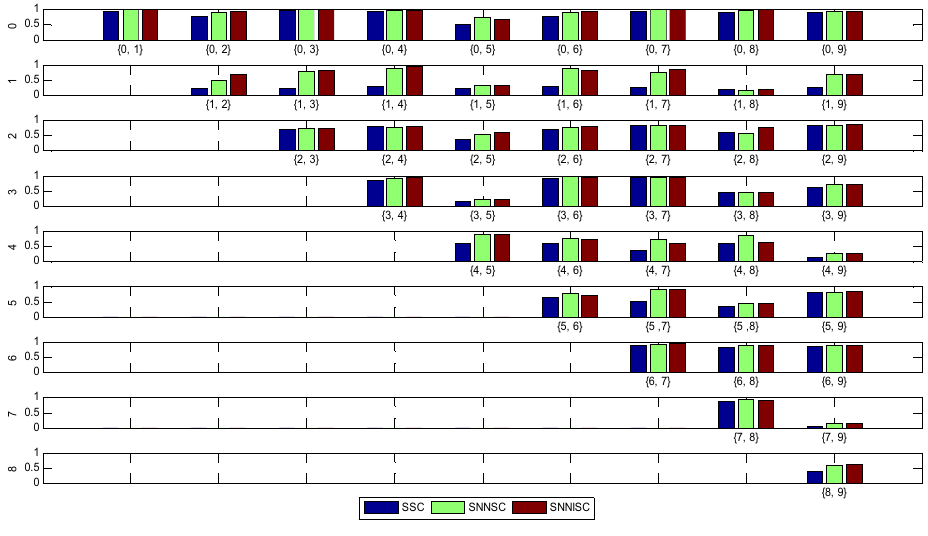
Figure 3. The ARI results of 45 tests on all pairs of 10